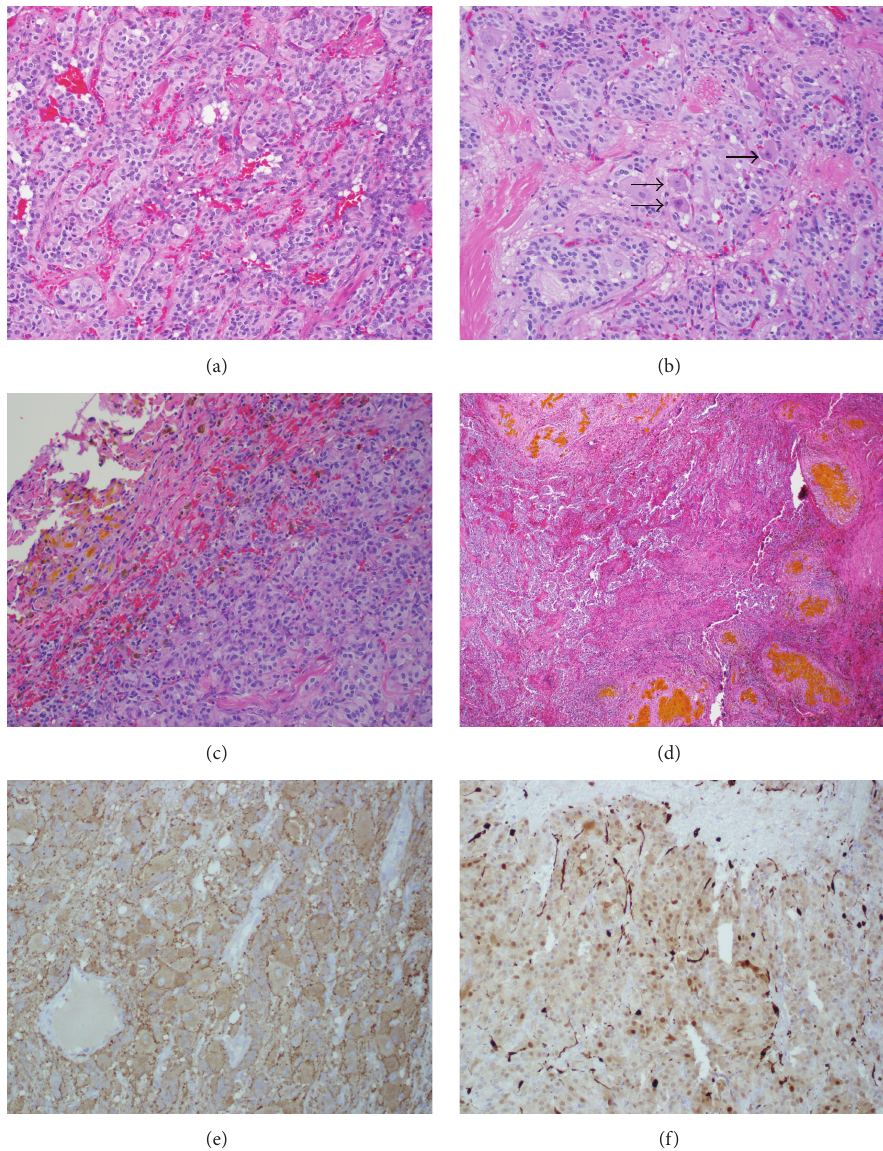
Figure 4: Gangliocytic paraganglioma. (a) Gangliocytic paraganglioma depicting nested arrangement of cells in a Zellballen pattern. H&E stain, 20x. (b) Gangliocytic paraganglioma with ganglion cells (arrow head). H&E stain, 40x. (c) Section of the tumor capsule showing pigmented macrophages (brown) and extracellular hemoglobin breakdown product (yellow). H&E stain, 4x. (d) Focus of remote hemorrhage toward the periphery of the tumor. H&E stain, 20x. (e) Synaptophysin stain positive (brown): positive for synaptic vesicle protein, 20x. (f) S100 stain positive for sustentacular cells (dark brown along edges of lobules),